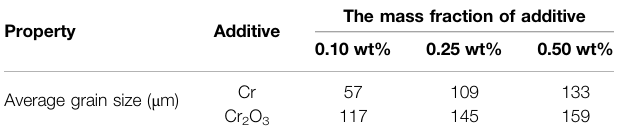
TABLE 8 | The average grain size of UO 2 pellets doped with different contents of Cr and Cr 2 O 3 . Property